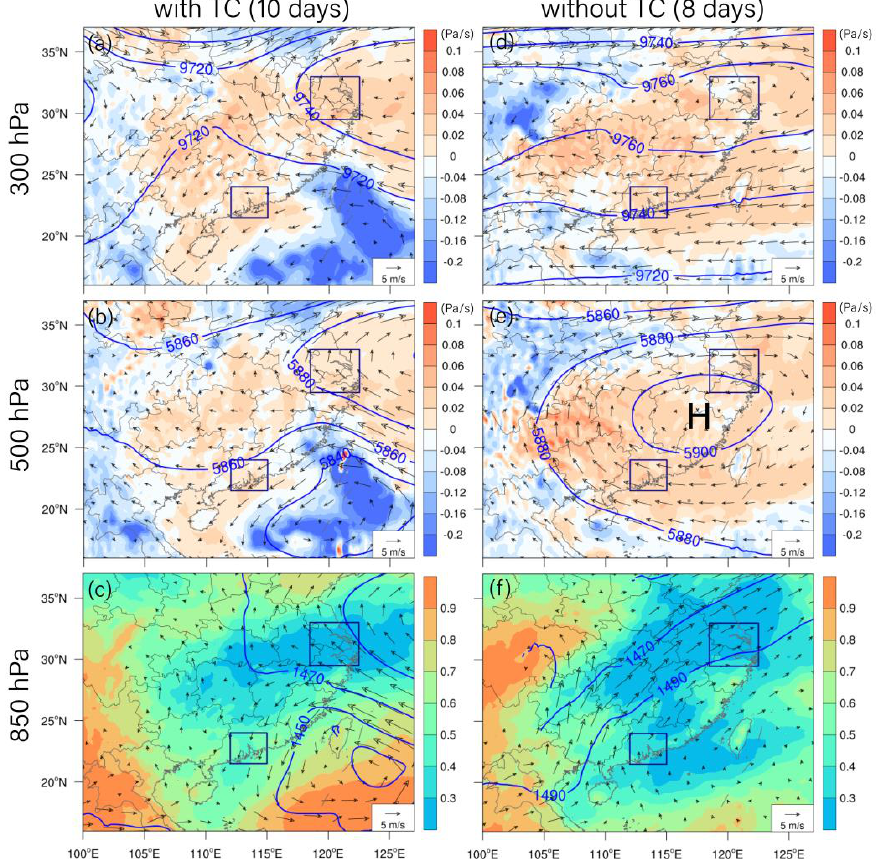
Figure 10. Synoptic backgrounds for the heatwaves simultaneously over both YRD and PRD regions (rectangular boxes), with TC (left) and without TC (right), respectively. Top panels ( a , d ) represent the 300 hPa GPT (blue contours; unit: gpm), horizontal wind vector (arrows), and vertical velocity (shadings; positive and negative value corresponds to descending and ascending motion). Middle panels ( b , e ) are same as the top panels except for at 500 hPa. Bottom panels ( c , f ) represent the 850 hPa GPH (blue contours; unit: gpm) and horizontal wind vector (arrows), and total cloud cover (shadings). Gray lines show the national and provincial boundaries and coastlines. The other 8 days are characterized by an extremely intense, extensive subtropical high throughout the troposphere, leading to downward motion and few clouds over most